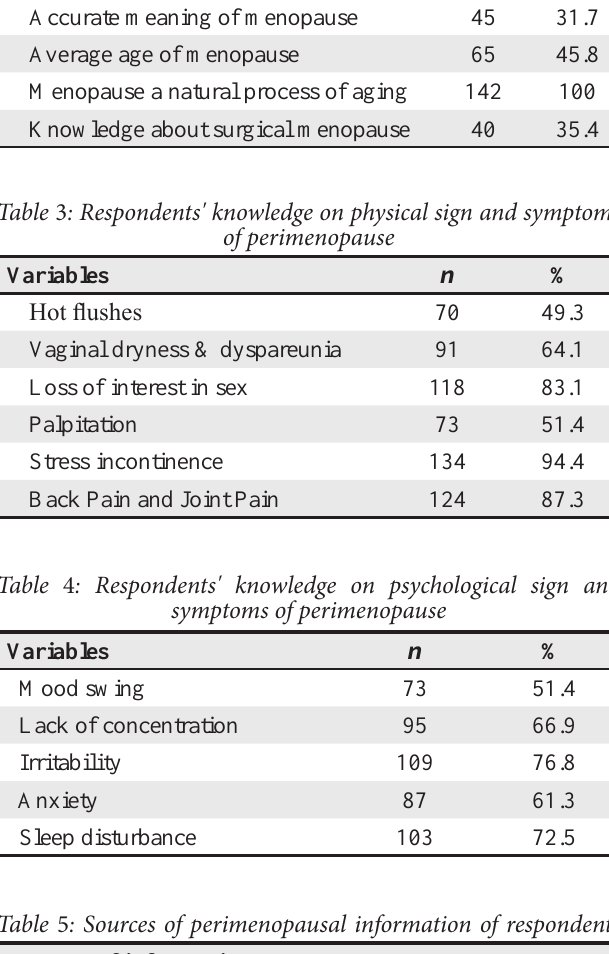
Table 5 : Sources of perimenopausal information of respondents